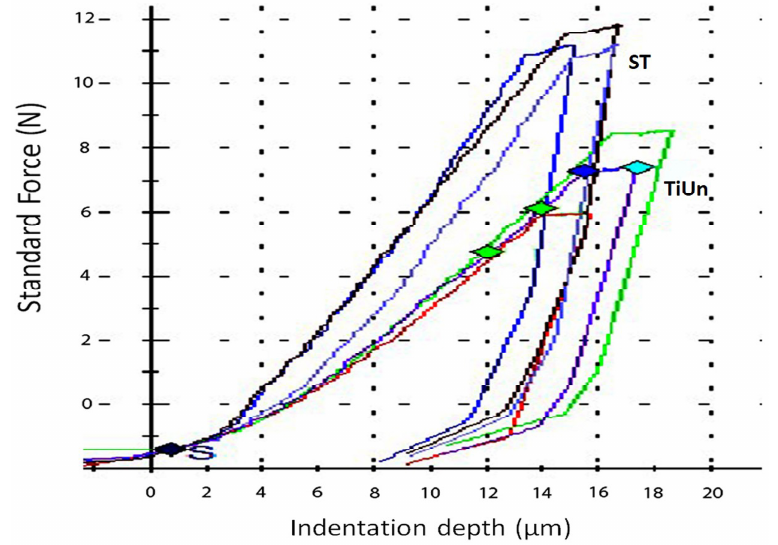
Figure 5. Representative load indentation depth curves for the ST and TiUn implants tested. Table 3. Mean values and standard deviations of the mechanical properties tested. There were no statistical differences identified between the groups ( p > 0.05). E IT , indentation modulus; ƞ IT , Elastic index, failed implants.